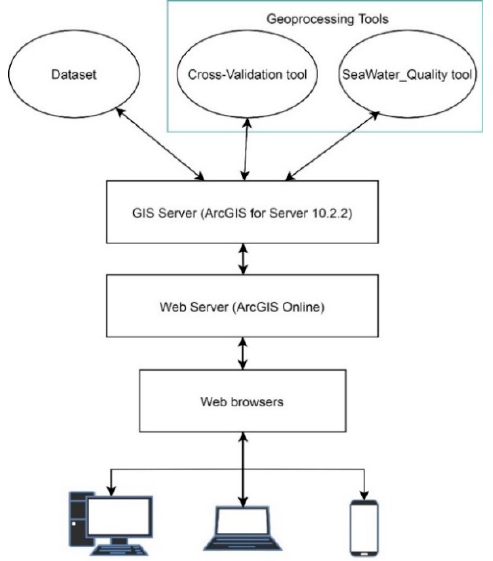
Figure 2. The architecture of the webGIS application.